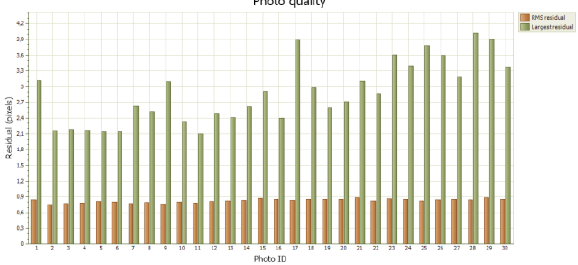
Figure 5. Photogrammetric residual value in pixel (RMS residual and biggest residual)